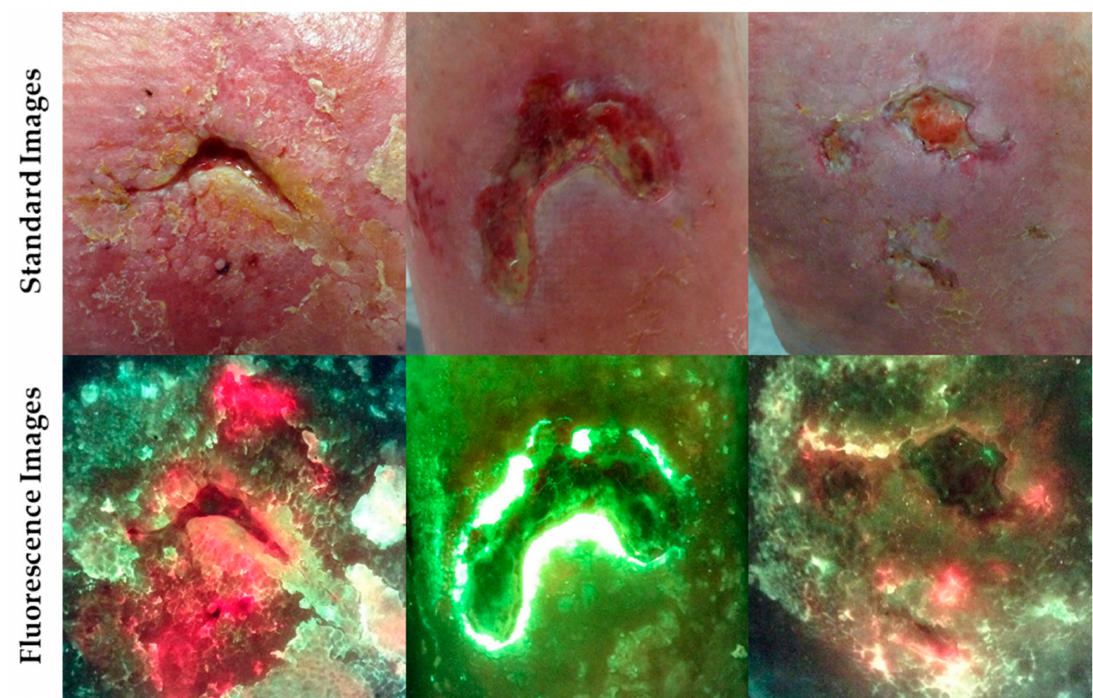
Figure 2. Examples of MolecuLight standard and fluorescence images. The MolecuLight i:X takes both standard and fluorescence images. These are 3 examples of wounds imaged with the MolecuLight. In fluorescence images, red or cyan fluorescence indicate the presence of bacterial loads >10 4 CFU/g or moderate-to-heavy loads. (Left) Venous leg ulcer with red fluorescence. Microbiology: 2 × 10 4 CFU/g. (Center) Venous leg ulcer with cyan fluorescence. Microbiology: 6 × 10 6 CFU/g. (Right) Venous leg ulcer with red fluorescence. Microbiology: 5 × 10 7